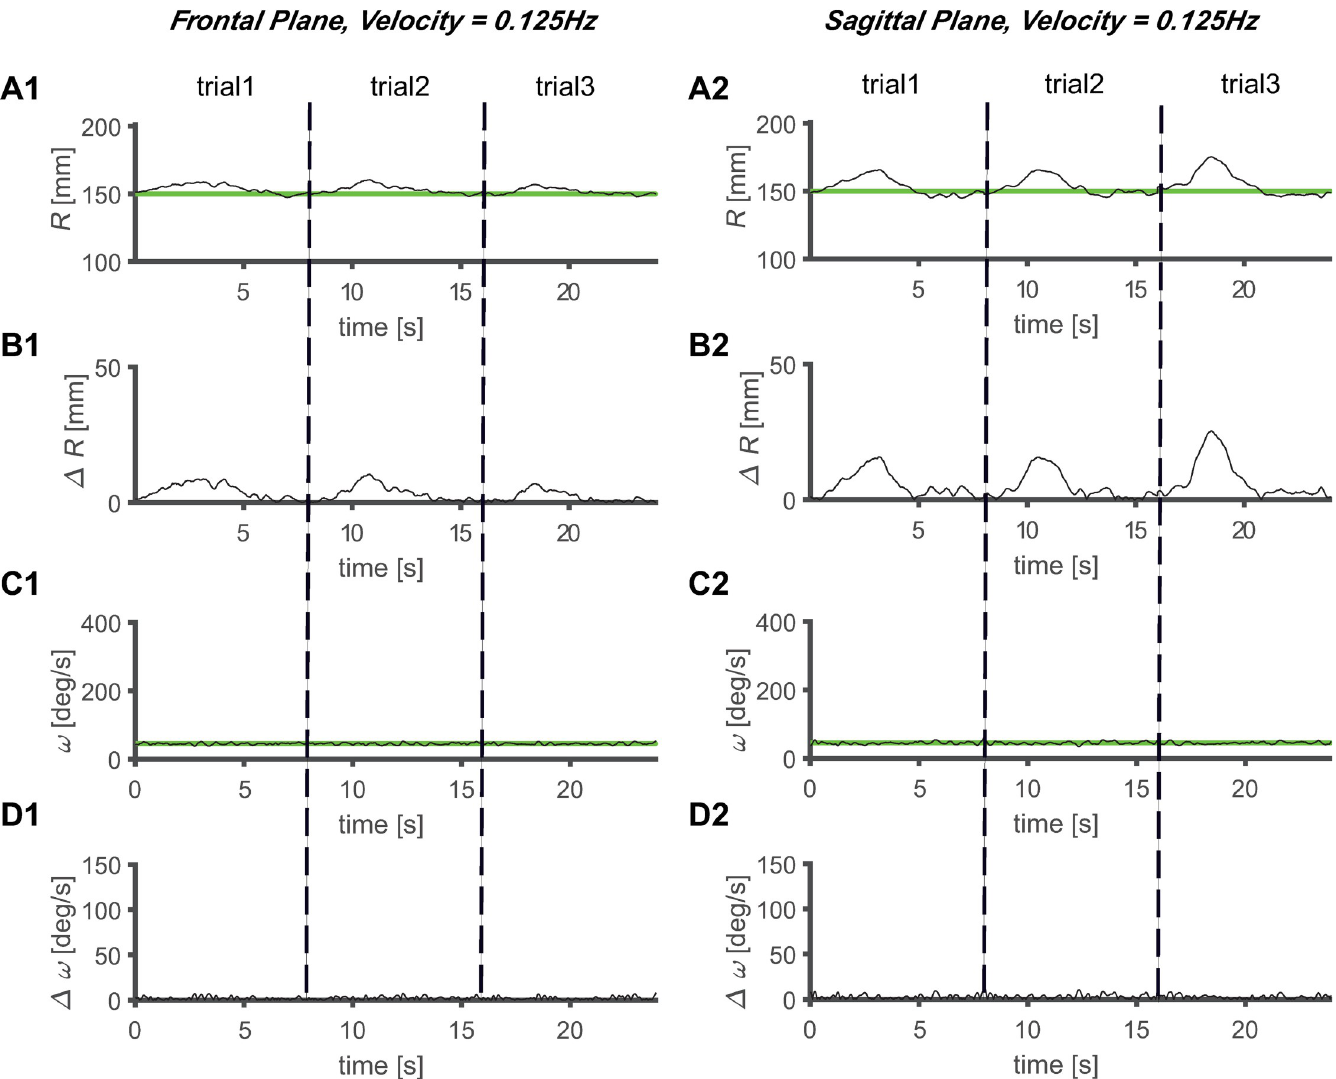
Fig 5. Average circular tracking movement at 0.125 Hz. The R value for three trials on the (A1) frontal plane (A1) and (A2) sagittal plane. Absolute value of Δ R on the (B1) frontal plane (B1) and (B2) sagittal plane, ω value for three trials on the (C1) frontal plane (C1) and (C2) sagittal plane, and absolute value of Δ ω on the (D1) frontal plane (D1) and (D2) sagittal